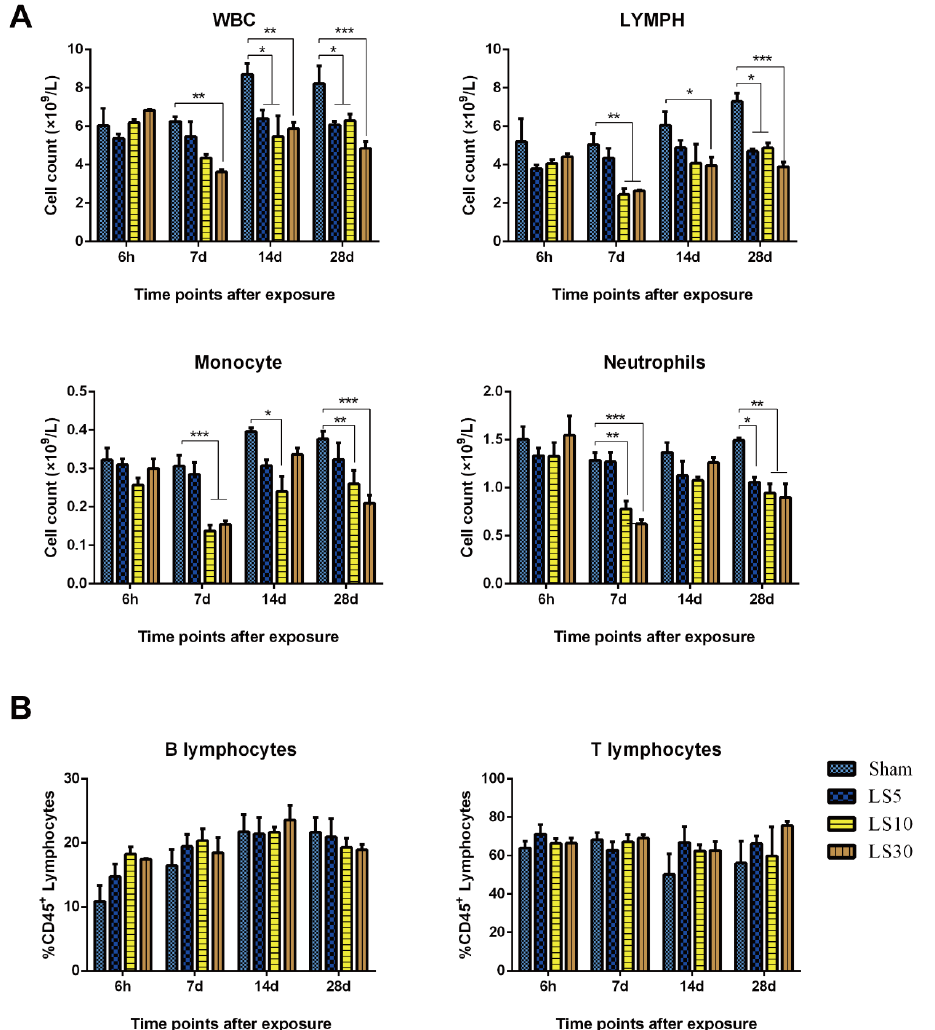
Figure 2. Multifrequency microwaves reduced white blood cells, including lymphocytes, monocytes, and neutrophils in peripheral blood. Wistar rats were exposed to multifrequency microwaves at average power densities of 5, 10, and 30 mW/cm 2 . At 6 h, 7 d, 14 d, and 28 d after exposure, heparin anticoagulant peripheral blood was collected from the inferior vena cava (IVC). The number of white blood cells, lymphocytes, monocytes, and neutrophils was analyzed by an automatic blood cell counter ( A ). Moreover, the immunophenotypes of lymphocytes, including T lymphocytes and B lymphocytes, were detected by flow cytometry ( B ). Data are shown as the mean ± s.e.m., * p < 0.05, ** p < 0.01, *** p < 0.001, vs. the corresponding groups.